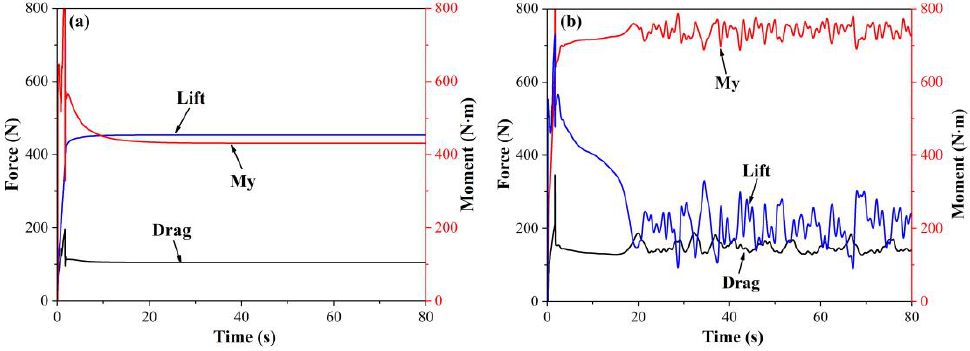
Figure 9. Simulated variations of the drag, lift, and moment as a function of time: ( a ) HG3; ( b ) HG1. Through the hydrodynamic analysis of the AUH with the AOA, it can be concluded that the HG3 hull has significantly better drag reduction lift performance and anti-overturning stability compared to HG1.